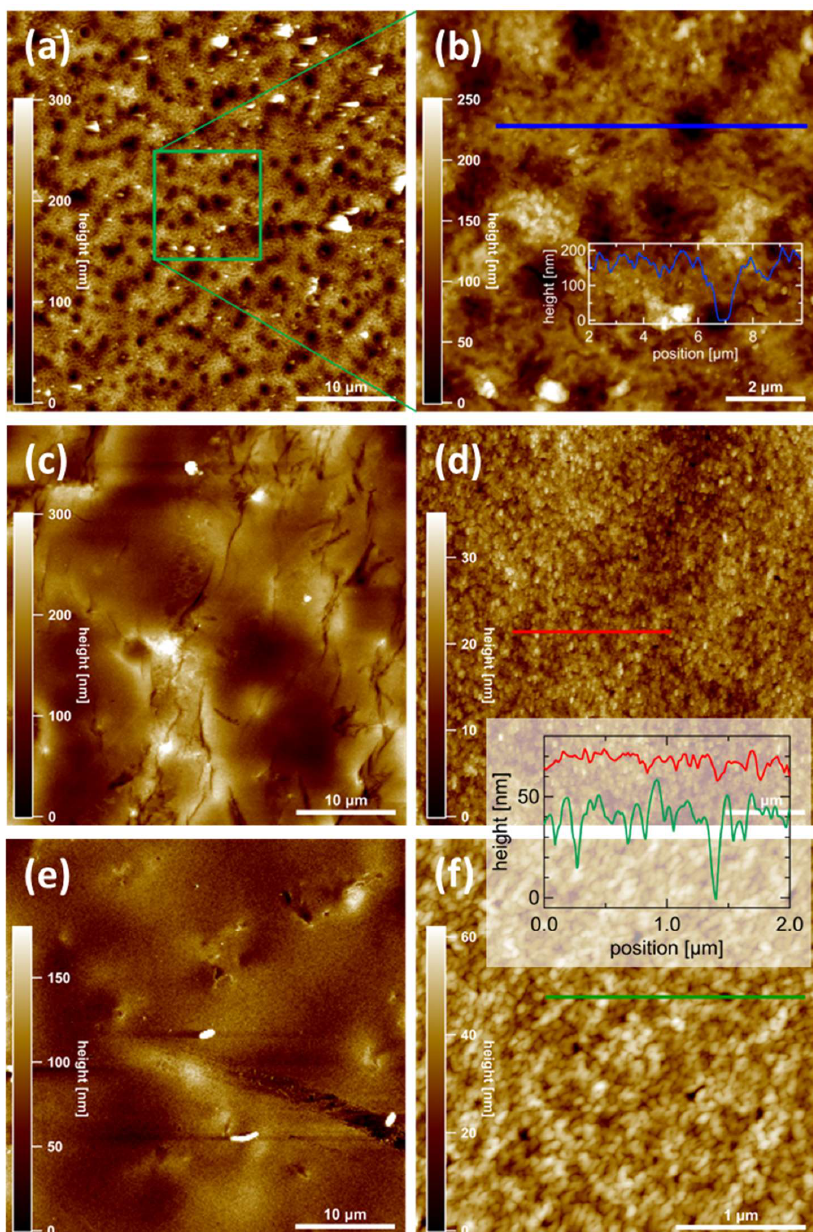
Figure 5. Morphology of membrane surfaces (at top sides) obtained by atomic force microscopy (AFM). Bright (dark) colors correspond to large (small) heights. The left column ( a , c , e ) contains overview images, while the right column ( b , d , f ) shows higher resolved images of the fine structure of three samples, i.e., (a,b) PILs B, (c,d) PILs BD2, (e,f) PILs D. Line profiles are shown as insets, taken at locations indicated by straight lines in the images (b,d,f).